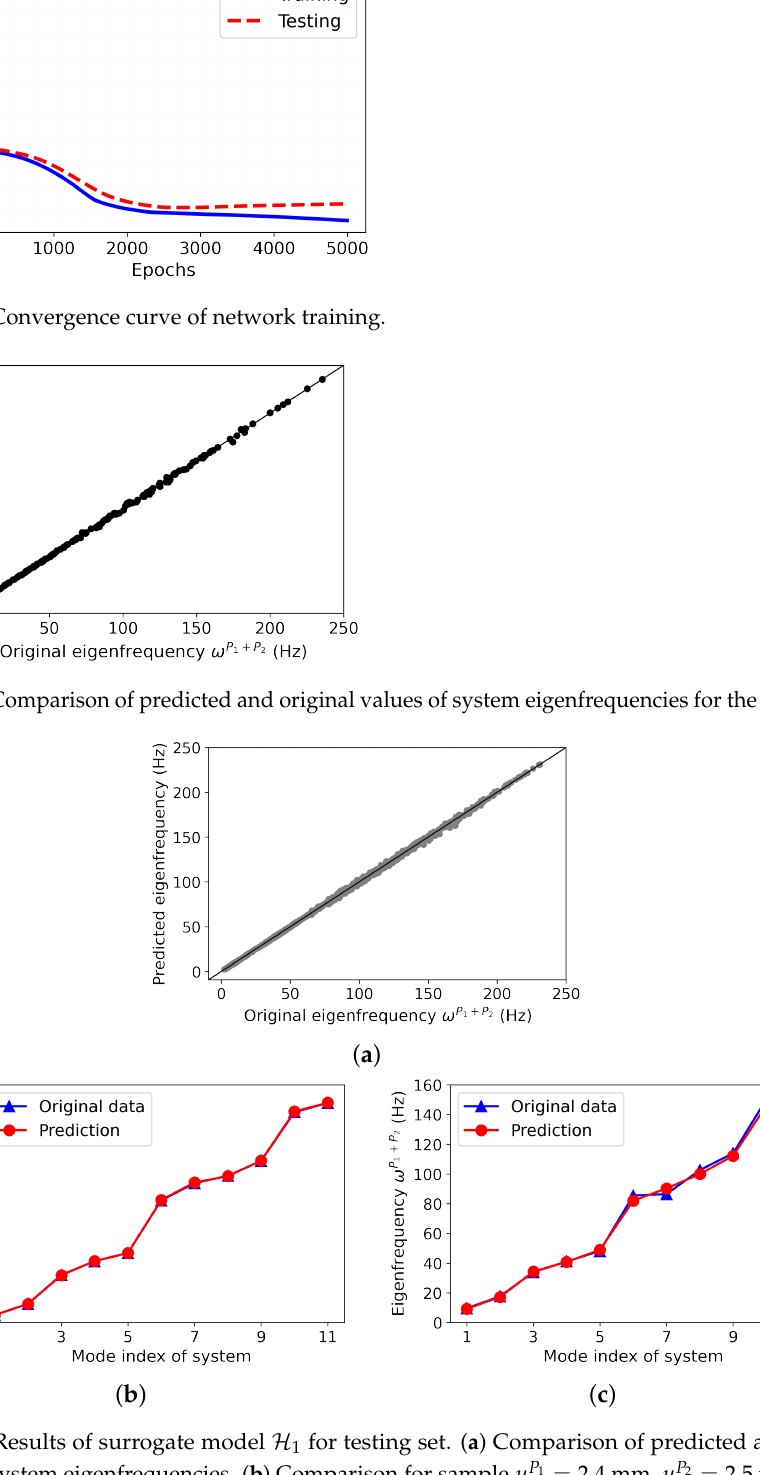
Figure 9. Results of surrogate model H 1 for testing set. ( a ) Comparison of predicted and original values of system eigenfrequencies. ( b ) Comparison for sample µ P 1 = 2.4 mm, µ P 2 = 2.5 mm in DOE with minimum MAPE = 0.347%. ( c ) Comparison for sample µ P 1 = 2.4 mm, µ P 2 = 1.2 mm in DOE with maximum MAPE =